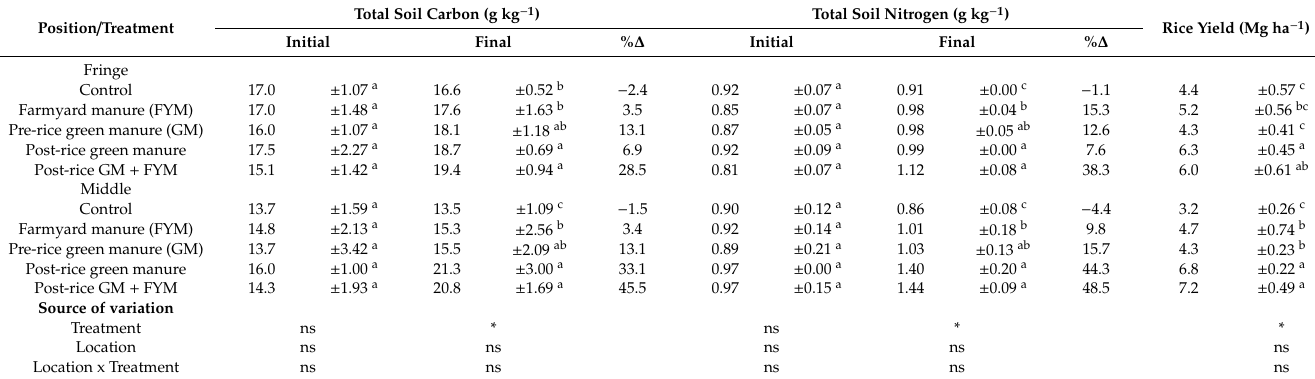
Rice Yield (Mg ha − 1 )